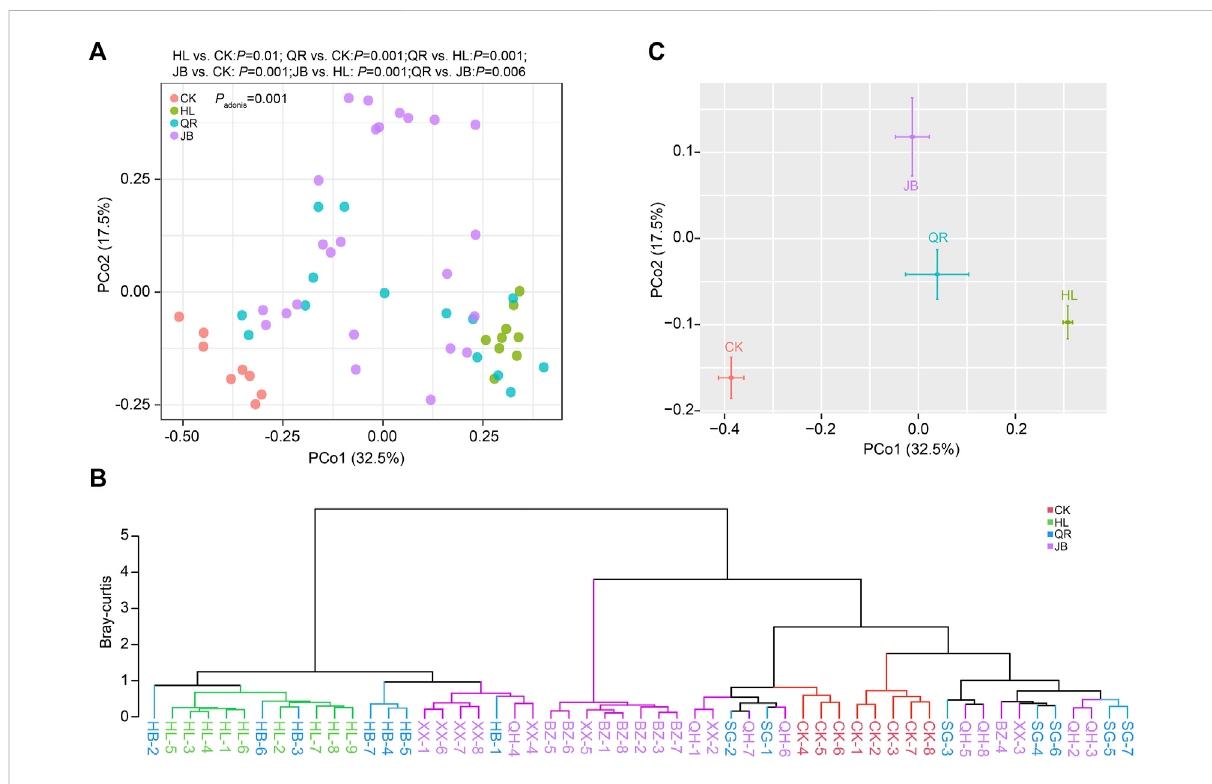
FIGURE 3 The alteration of gut microbial structure after antipyretic and diaphoretic drugs treatment. The structure of gut bacteria was assessed by Principalcoordinateanalysis(PCoA)whichwaspresentedbysamples (A) ormergedgroups (C) . (B)